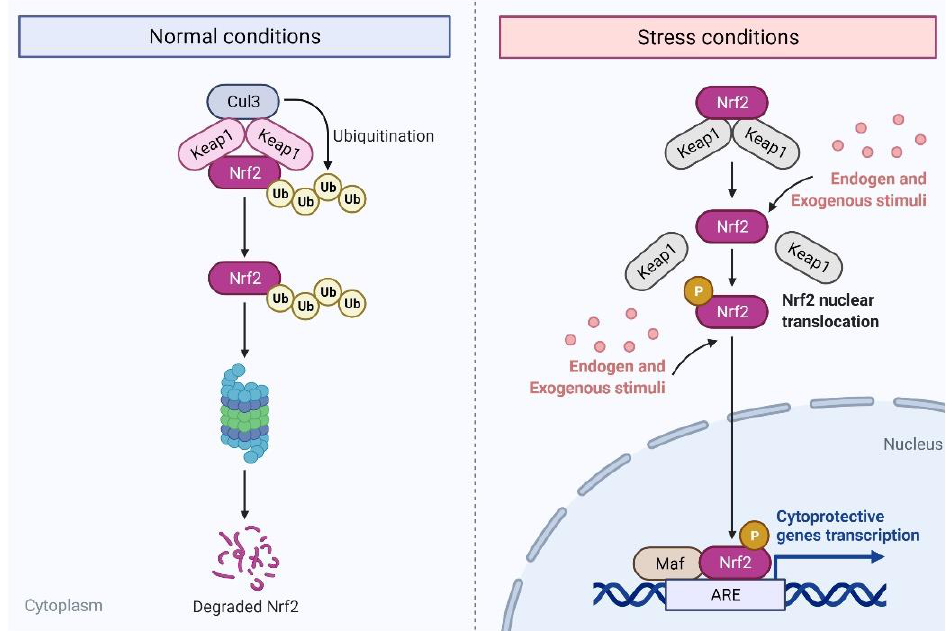
Figure 1. States of Nrf2 in normal conditions and under stress by various stimuli. ARE, antioxidant response element; Keap1, Kelch-like ECH-associated protein 1; Maf, avian musculoaponeurotic fibrosarcoma.